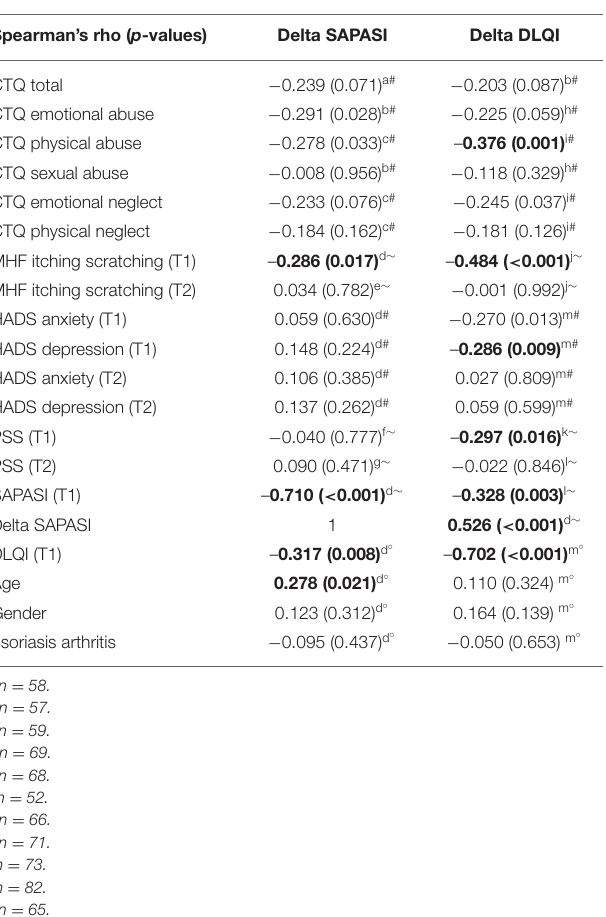
TABLE 3 | Correlation analyses between change scores of psoriasis severity (Delta SAPASI), skin-related quality of life (Delta DLQI) and childhood trauma (CTQ, subscales), itching/scratching (MHF), anxiety/depression (HADS), perceived stress (PSS), age, gender and psoriasis arthritis.